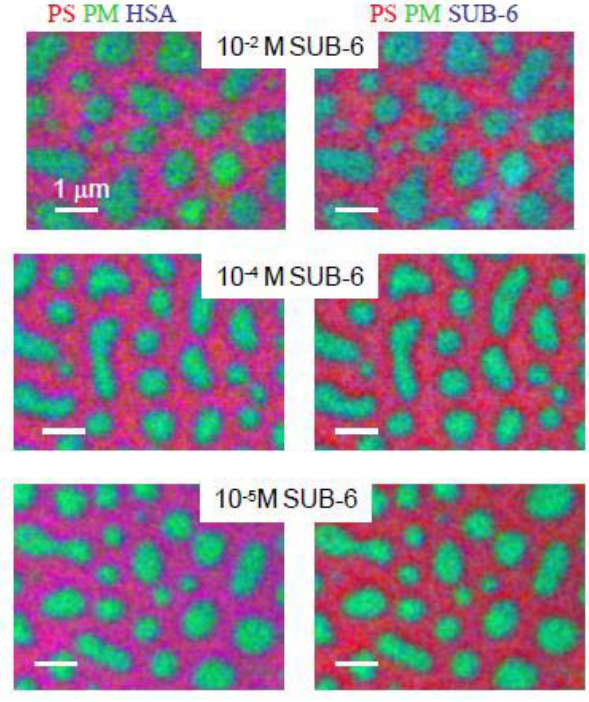
Figure 6. Color-coded rescaled component maps for SUB-6/HSA mix adsorbed to PS/PMMA at SUB-6 concentration (top) 1 × 10 –2 mg/mL, (middle) 1 × 10 –4 mg/mL, (bottom) 1 × 10 –5 mg/mL, in each case, with the. HSA concentration held unchanged at 0.05 mg/mL. PS = red, PMMA = green, HSA = blue, left, SUB-6 = blue, right [30] (reproduced with permission of the